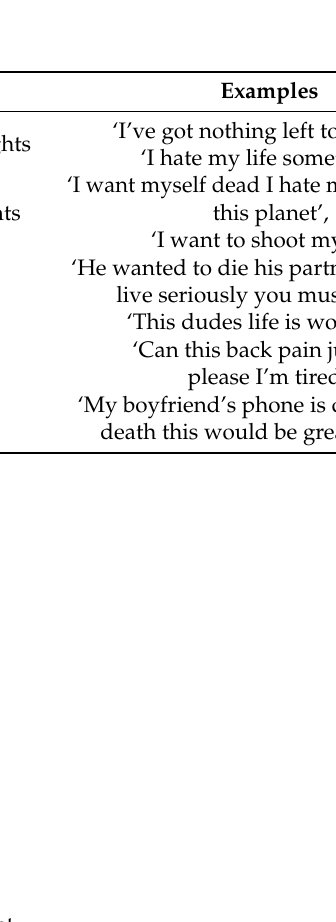
Figure 1. Class distribution of experimental dataset. Table 1. Data Annotation Rules.